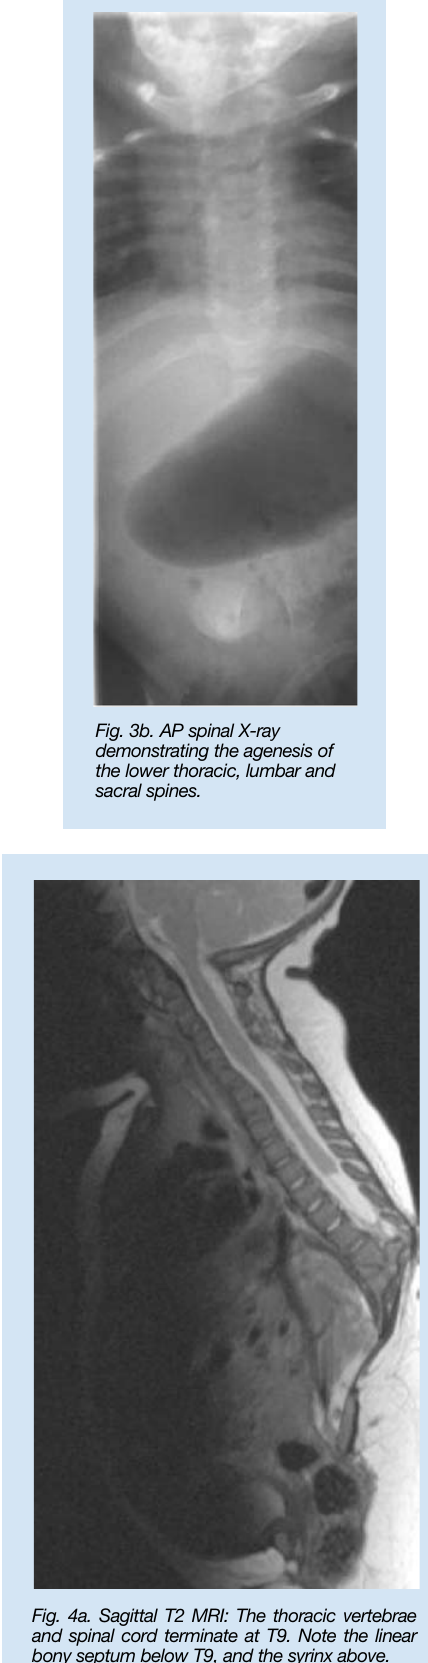
Fig. 4a. Sagittal T2 MRI: The thoracic vertebrae and spinal cord terminate at T9. Note the linear bony septum below T9, and the syrinx